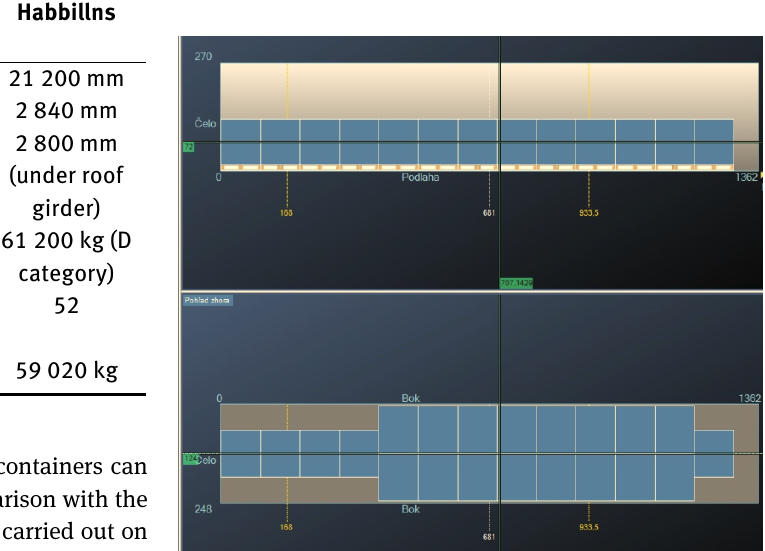
Figure 4: Diagram of load distribution of 21 IBC containers on the semitrailer with payload of 24 t [authors based on Truck Stow and 13]